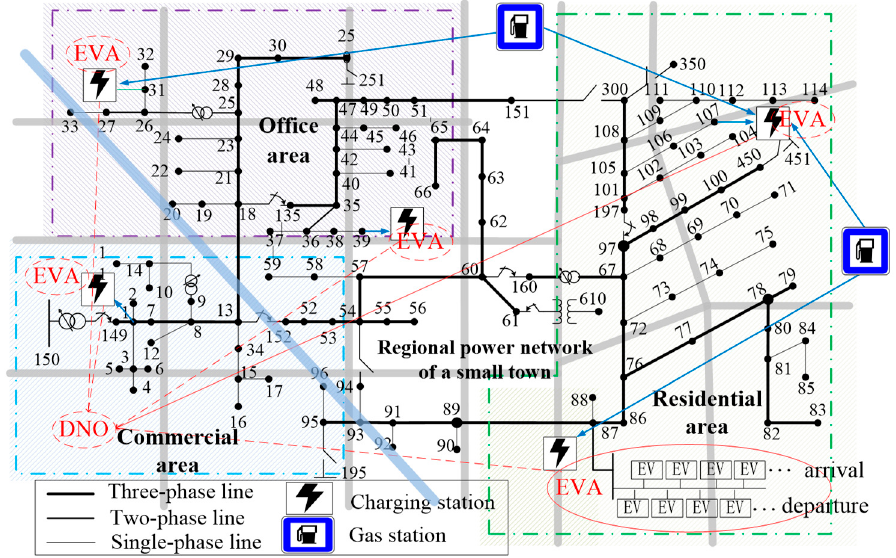
Figure 3. EV charging facilities integrated into the 123-bus distribution network. Table 1. Simulation parameters for EV type and EV charging infrastructure.